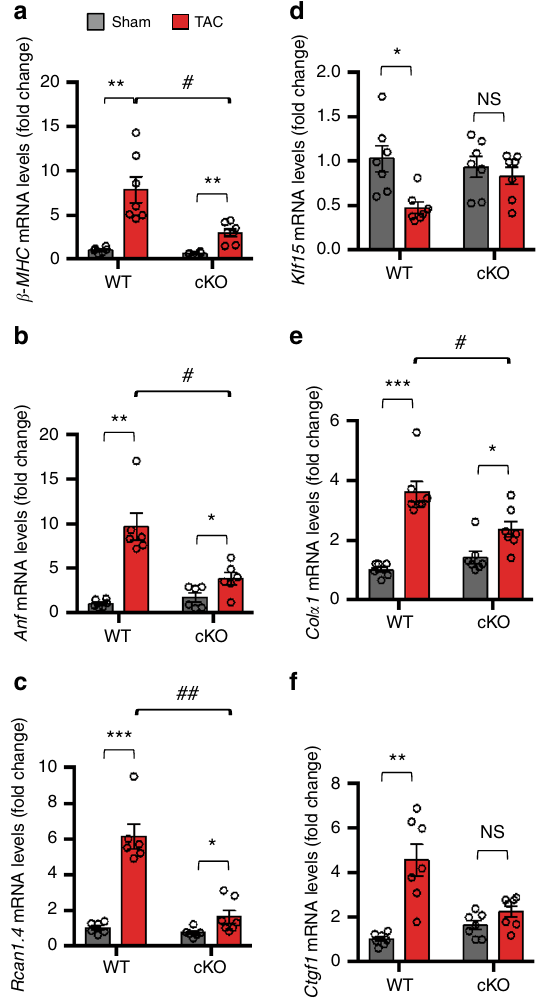
Fig. 6 Reactivation of fetal and fi brotic gene programs in response to TAC is blunted in cKO hearts. a – f qRT-PCR analyses of mRNA levels of the indicated genes in 3-week TAC and sham LVs of FoxO1-WT [WT, n = 13 ( a ), 12 ( b , c ), and 14 ( d – f )] and FoxO1-cKO [cKO, n = 13 ( a ), 12 ( b , c ), and 14 ( d – f )] mice. mRNA levels of ribosomal 18S were used as control. In all panels, data are depicted as mean ± SEM. * p < 0.05 vs Sham; ** p < 0.01 vs sham; *** p < 0.001 vs sham; # p < 0.05 vs WT, ## p < 0.001 vs WT; NS not statistically signi fi cant. Statistical analyses were conducted using a two- tailed, unpaired Student ’ s t